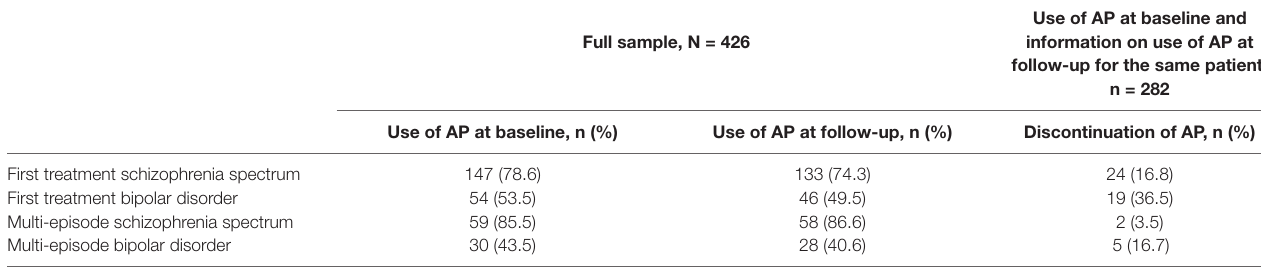
TABLE 4 | Use of antipsychotic at baseline and